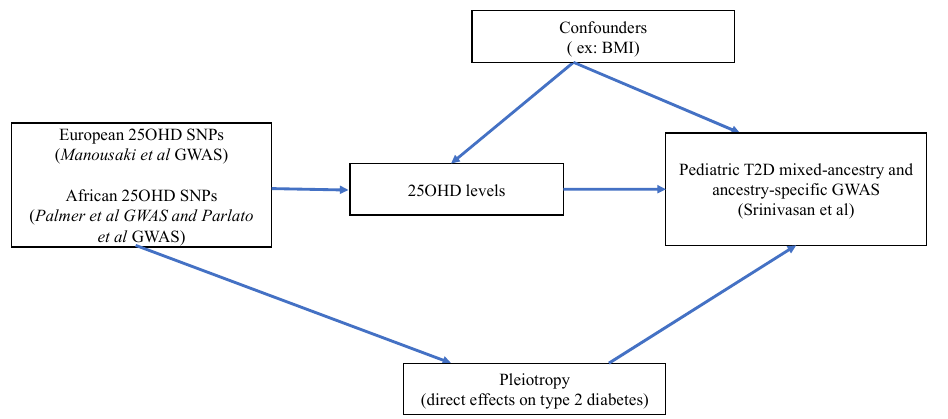
Figure 2. MR Direct Acyclic Graph (DAG) of our study.